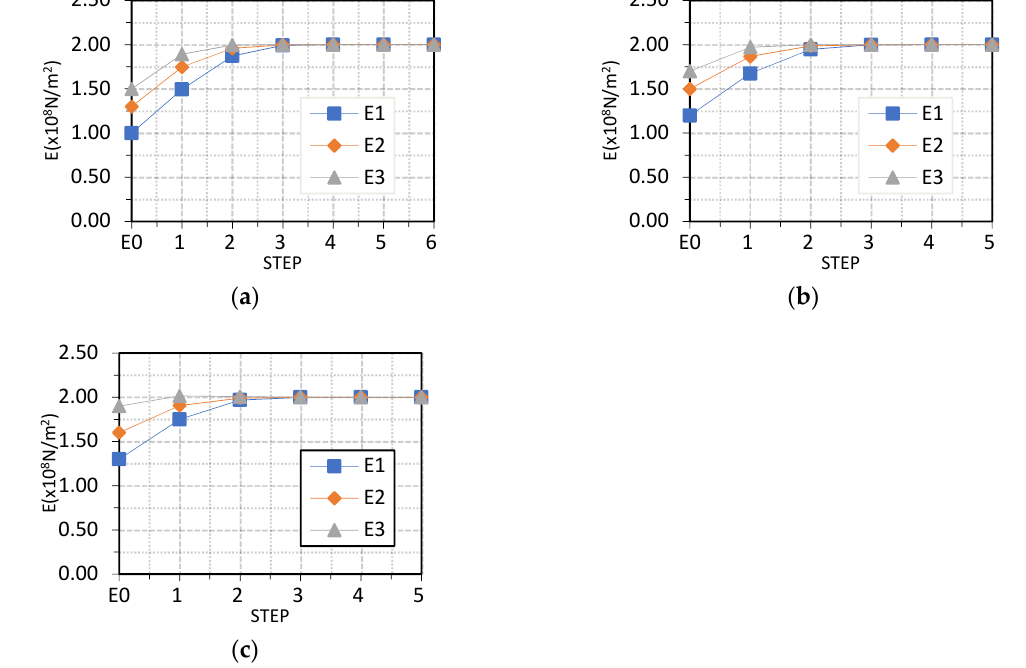
Figure 2. Results under different sets of initial values. ( a ) Results under the first set of initial values. ( b ) Results under the second set of initial values. ( c ) Result under the third set of initial values.